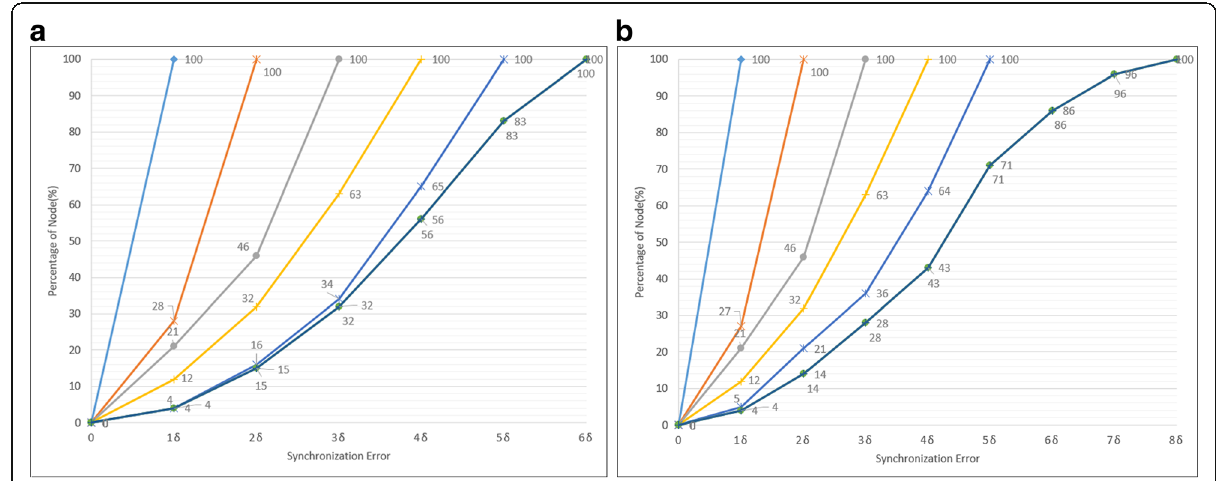
Fig. 6 Comparison of synchronization error when MBATS employs the designed path. a The densely deployed network case. b The sparsely deployed network